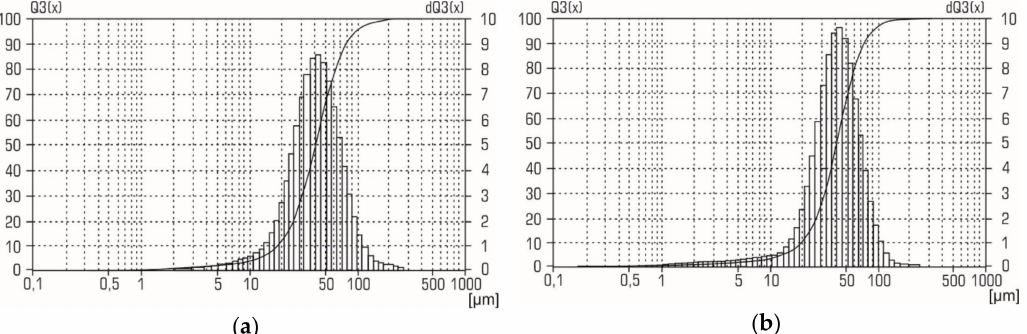
Figure 8. Particle size distribution of aluminum-alumina powder composites with the alumina content a ) 10.0 wt. % and b ) 20.0 wt.